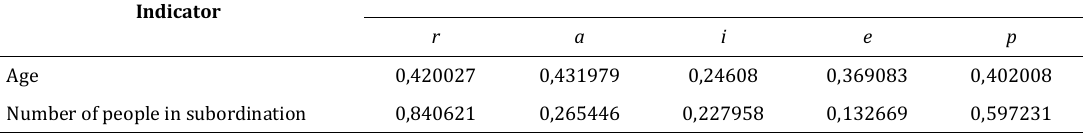
Table 2: Value of the correlation coefficient